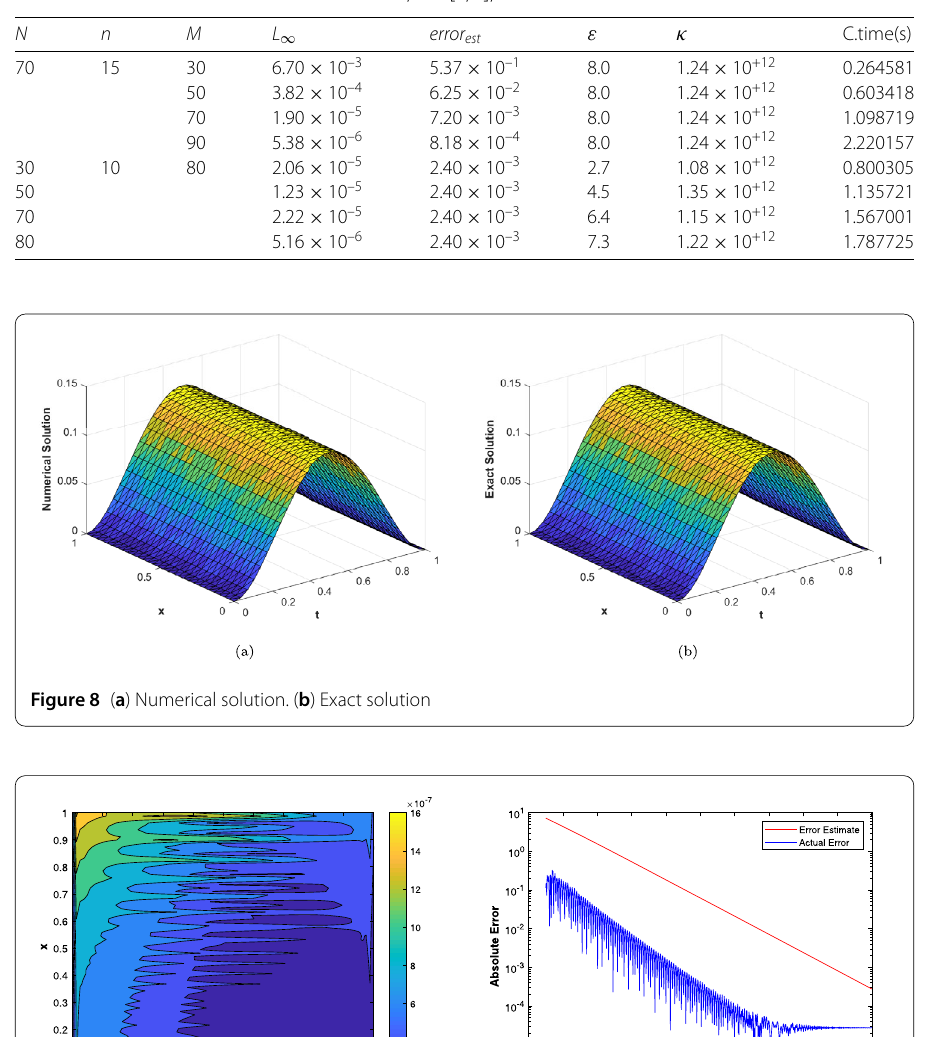
time instability issues were avoided. The local meshless method produced sparse differ- entiation matrices and the issues of ill conditioning and shape parameter sensitivity were resolved. We discussed the convergence and stability of the method. Some numerical ex- periments were performed on one dimensional problems with a CF derivative for different fractional orders. Numerical results confirmed the stability and high accuracy of the pro- posed method. The obtained results ensured the efficiency and applicability of the method for such